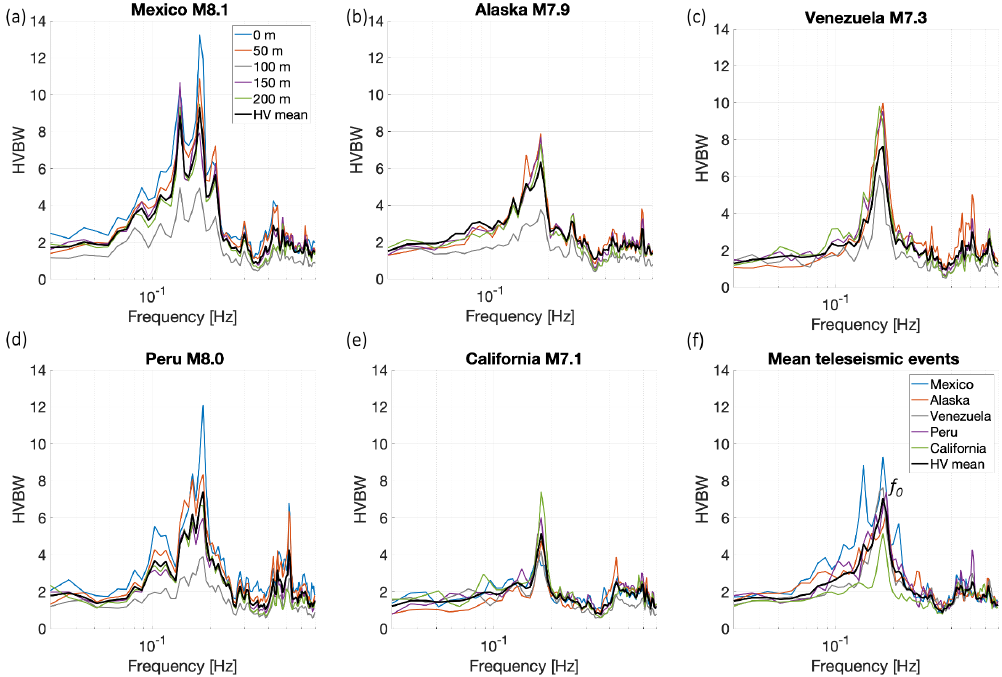
Figure 5. HVBWs from five teleseismic events recorded at station G24: (a) Mexico (M8.1), (b) Alaska (M7.9), (c) Venezuela (M7.3), (d) Peru (M8.0) and (e) southern California (M7.1). The coloured lines show the HVBW curves at different depth levels; the black lines show the average per event. (f) From the five mean HVBWs (black lines in panels a–e ), a second averaging is performed to estimate the final HVBW for this station. The black line is the calculated mean HVBW over the five event HVBWs (coloured lines). The peak frequency of the mean HVBW ( f 0 ) is picked for shear-wave velocity calculations using Eq.